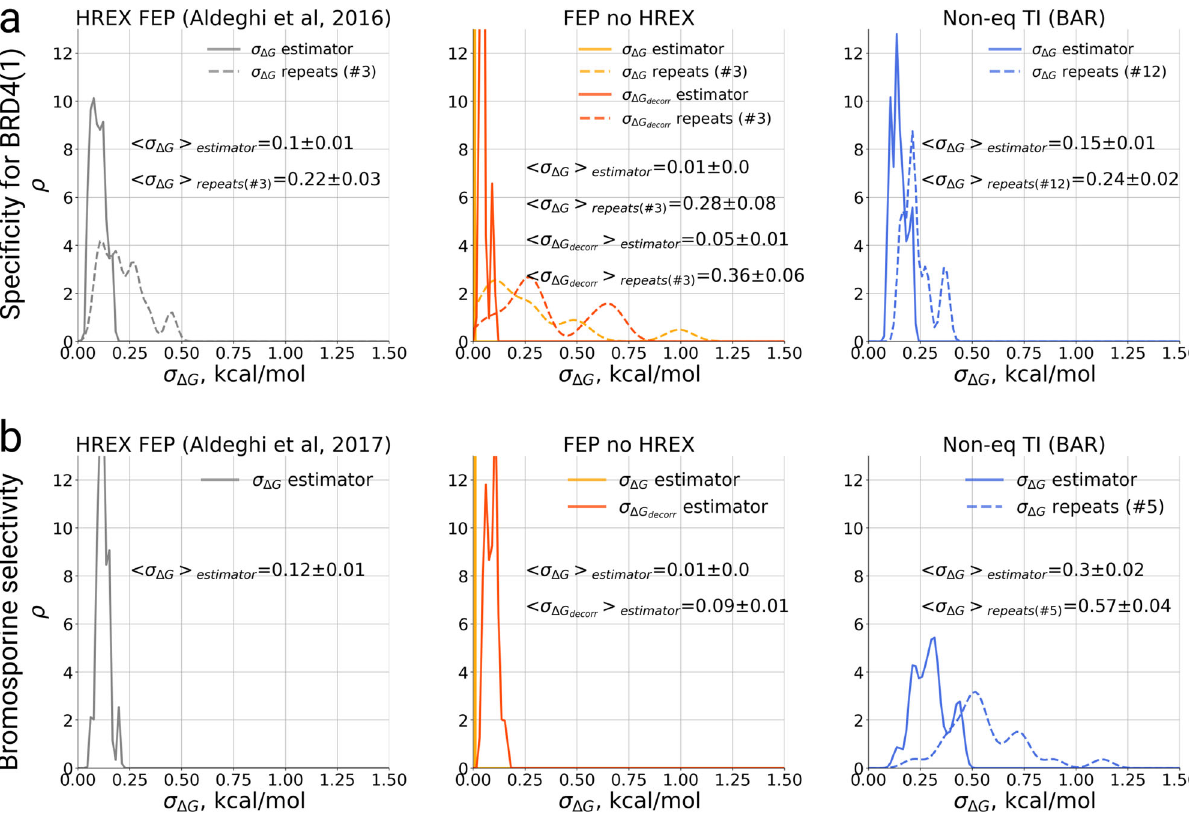
Fig. 8 Distributions of uncertainty estimates for the ligand – protein coupling free energies. The solid line depicts estimator uncertainty calculated from single simulation repeats. The dashed line shows the uncertainties obtained from independent simulation repeats. For the FEP no HREX case the uncertainty estimators from the whole data, as well as from uncorrelated samples ( σ Δ Gdecorr ) are shown. a A set of 11 ligands binding to BRD4(1). b Bromosporine binding to 22 bromodomain proteins. The uncertainties denote standard errors of the